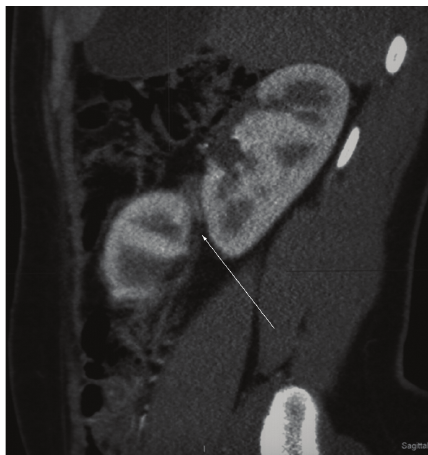
Figure 2: 16-year-old adolescent male with left-to-right crossed renal ectopia. Sagittal CT scan with intravenous contrast, corticomedullary phase. Showing clear plane of separation between the two kidneys (white arrow), each kidney having its own Gerota’s fascia.